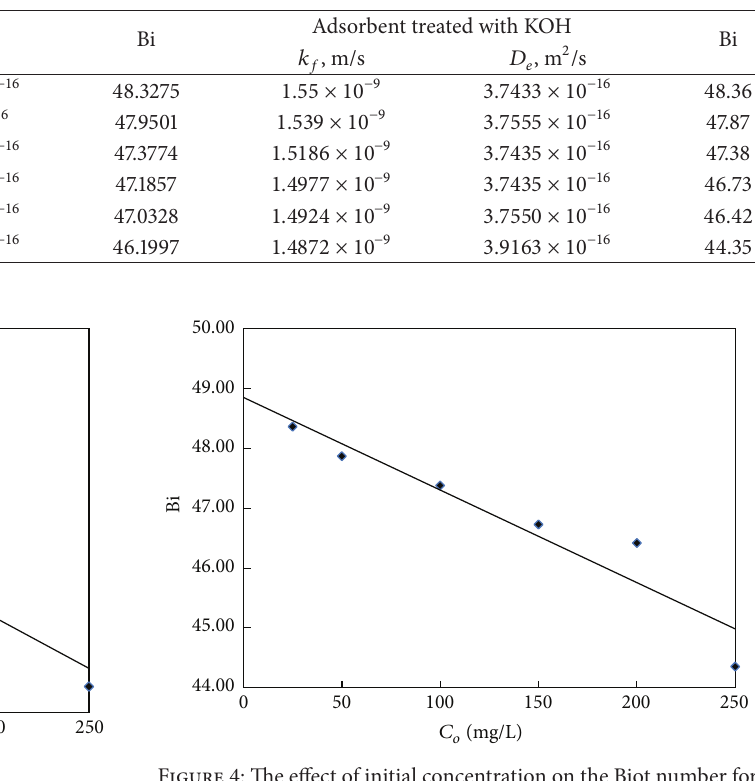
Table 9: The values of Biot number for both adsorbents at different initial concentrations.